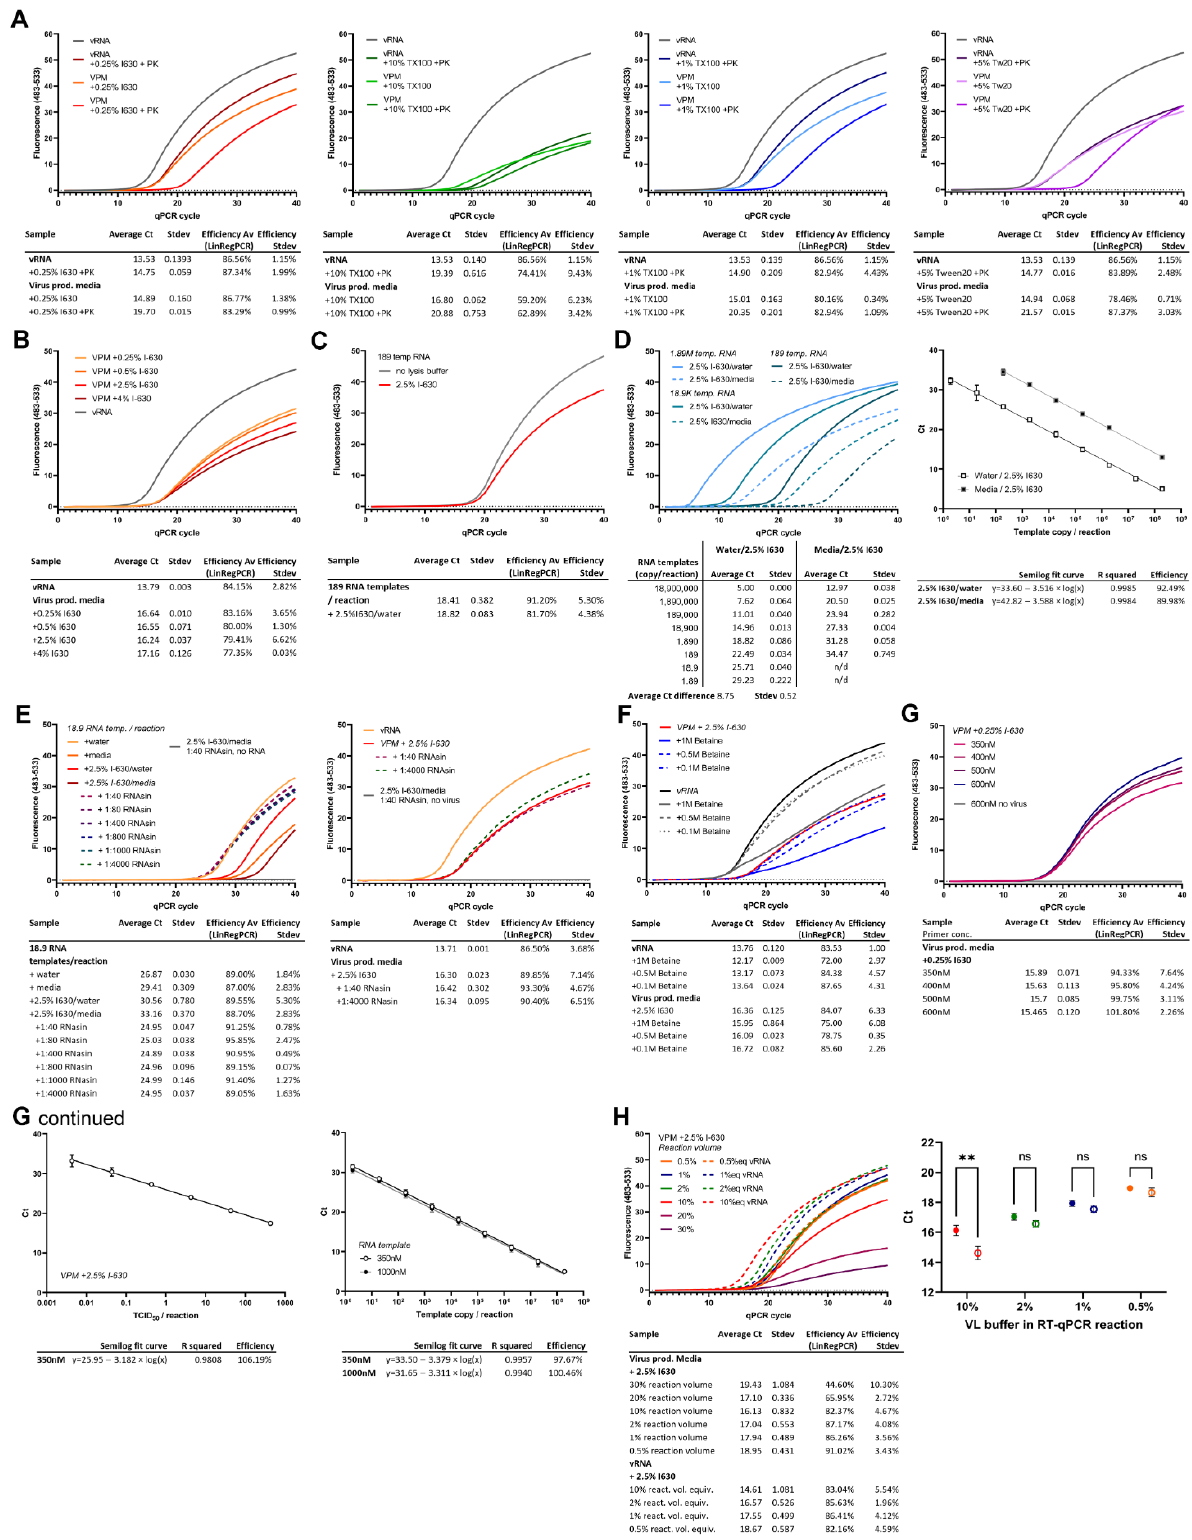
Figure 2. Direct lysis RT-qPCR. Virus production medium (VPM), corresponding amounts of vRNA, or template RNA (as indicated in individual experiments) were lysed 1:1 with detergent lysis buffer for 20 min at room temperature before addition to a 1-step RT-qPCR reaction at 10% of the reaction volume using 350 nM symmetric concentrations of the CDC N3 pair, unless otherwise indicated. Ct values as calculated using the LightCycler software using the 2nd derivative of the max calculation.